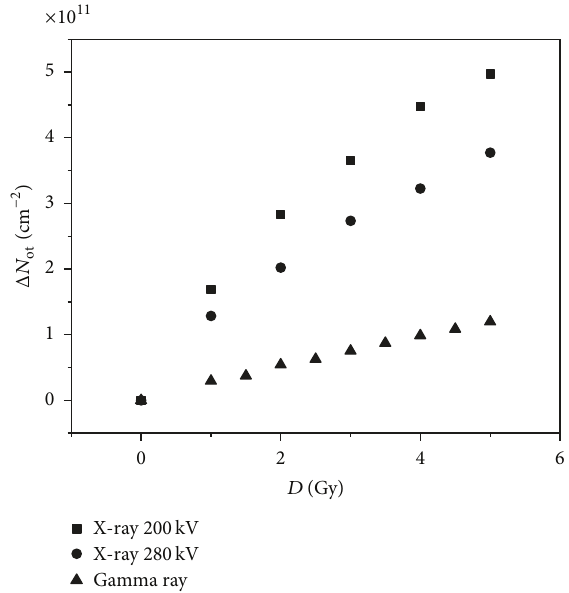
Figure 9: Δ𝑁 during 200kV and 280 kV X-ray as well as gamma- ot ray irradiation with +5V gate